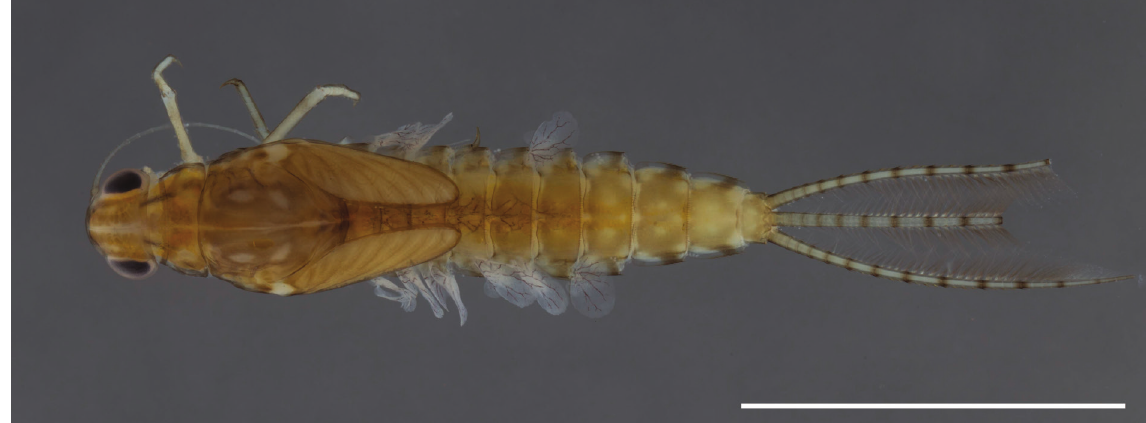
Fig. 4. Cloeon perkinsi , nymph. Habitus. Specimen collected in Hula swamp, Israel. Scale bar = 5